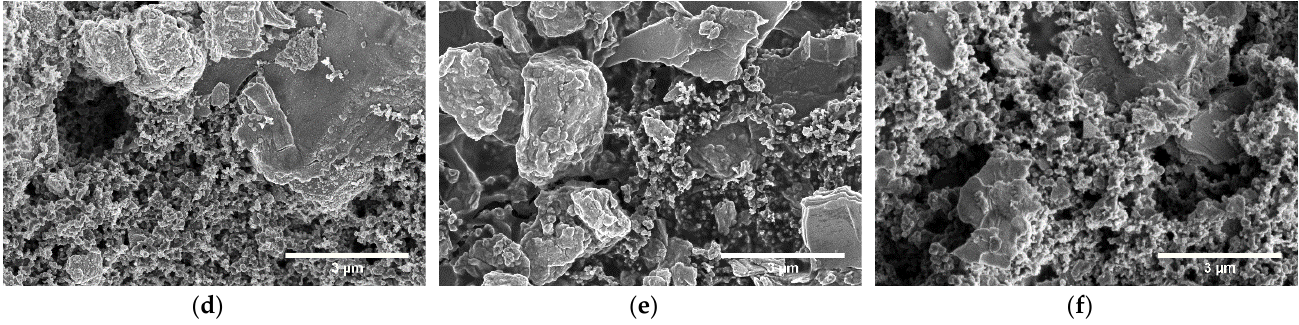
Figure 3. SEM of Na 0.67 MnO 2 electrodes prepared with ( a , d ) PVDF; ( b , e ) Na alginate and ( c , f ) TBA alginate binders. The length of the scale bar is 10 μm for images in the top row and 3 μm for images in the bottom row.